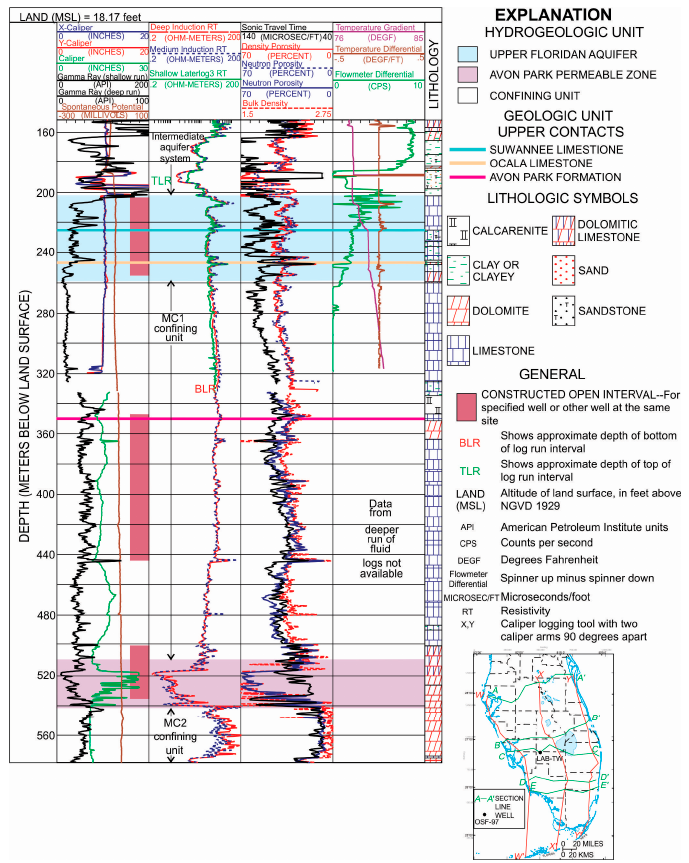
Figure 3. Hydrogeologic units at the LAB-TW test well site located at the Caloosahatchee River (C- 43) West Basin Storage Reservoir (from Reese and Richardson [23]).